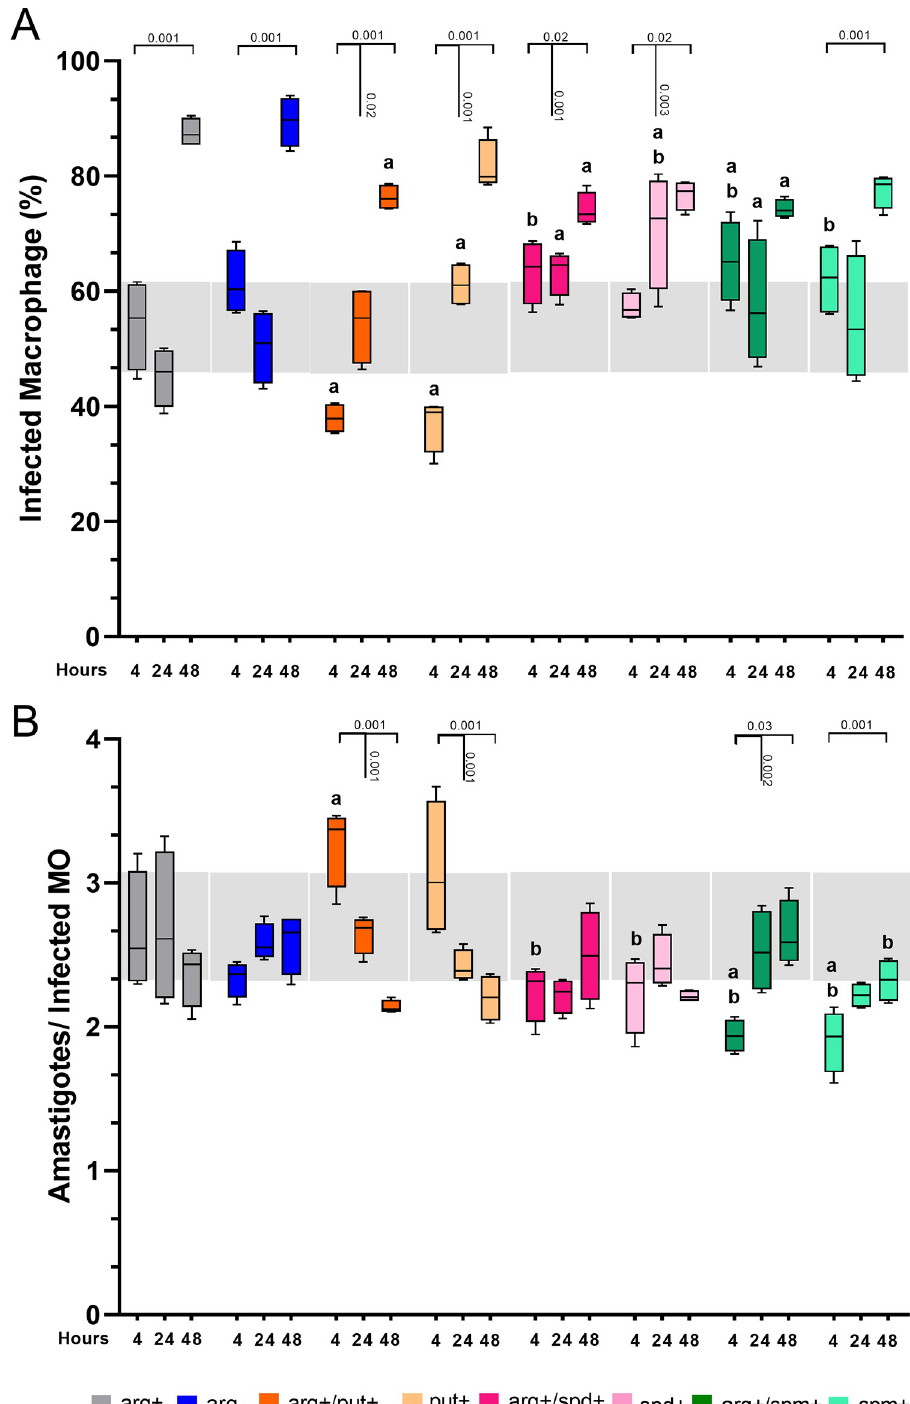
Fig 1. Effect of polyamine supplementation in infection of BALB/c macrophages with L . amazonensis . Macrophages (2x10 5 ) were deprived (arg-) or supplemented (arg+) with L-arginine and/or putrescine (put+), spermidine (spd+), spermine (spm+) concomitant to L . amazonensis infection (MOI 5:1) for 4h, and after 24 and 48h in complete medium. Cells were stained using Panoptic to determine the percentage of infected macrophage (A) and the number of amastigotes per macrophage (B). Each box represents the mean ± S.E.M. of 3 independent experiments (n = 500 macrophages). Statistical analysis using Two-Way ANOVA with mixed-effects, post hoc test Sidak’s multiple comparisons: a, p � 0,05 comparing to arg+; b, p � 0,05 comparing to arg+/put+ and put+.